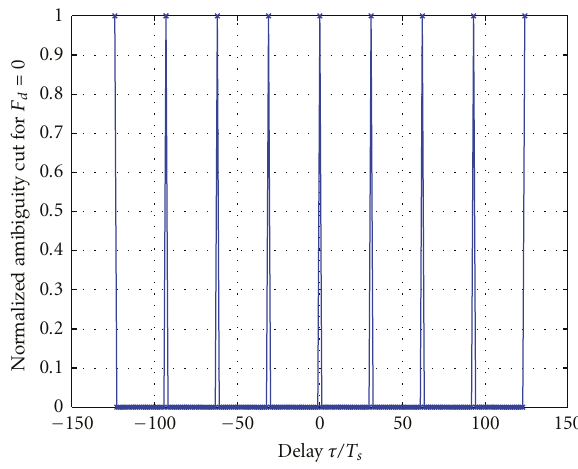
Figure 1: Periodic autocorrelation property of optimized punc- tured